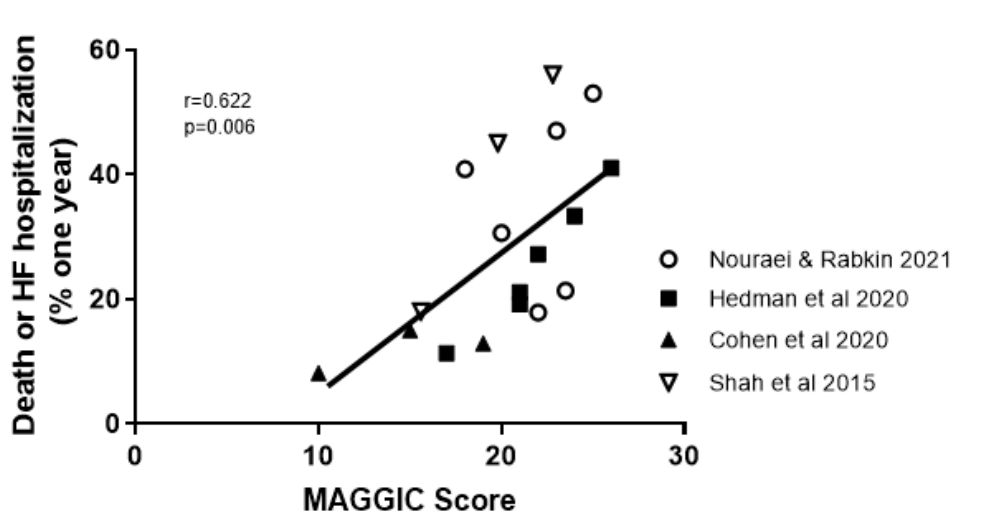
Figure 3: Correlation between the MAGGIC score in the papers that calculated it and the one year outcome